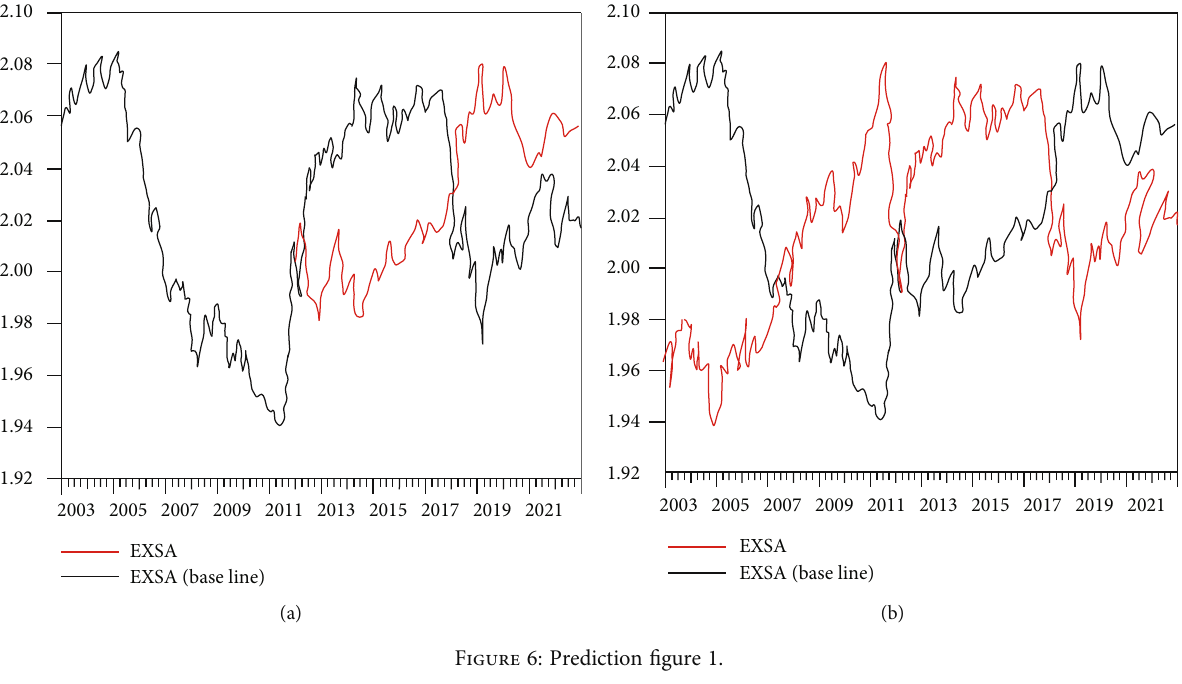
Figure 6: Prediction fi gure Algorithm 6. The learning algorithm is as follows: the algo-